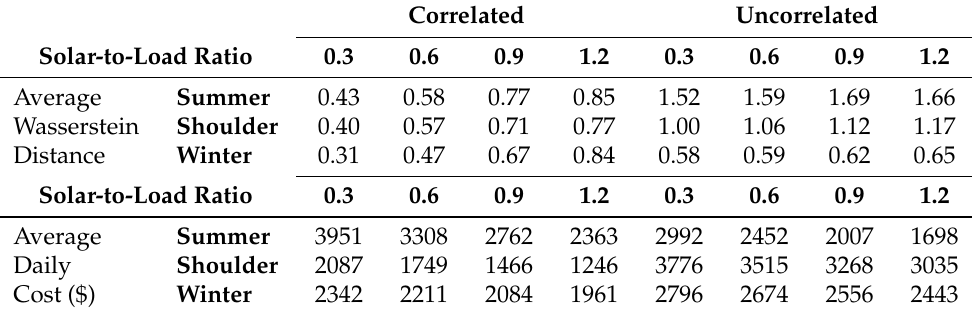
Table 3. Result summary for abnormal